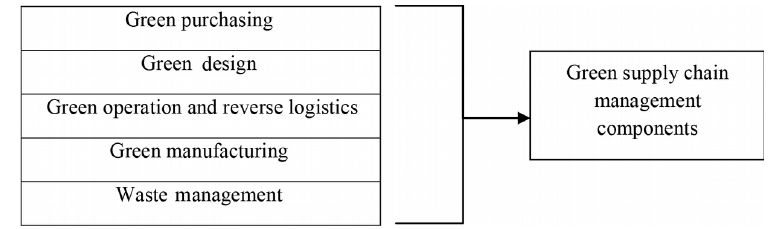
Figure 2. Green supply chain management components (Heravani et al.